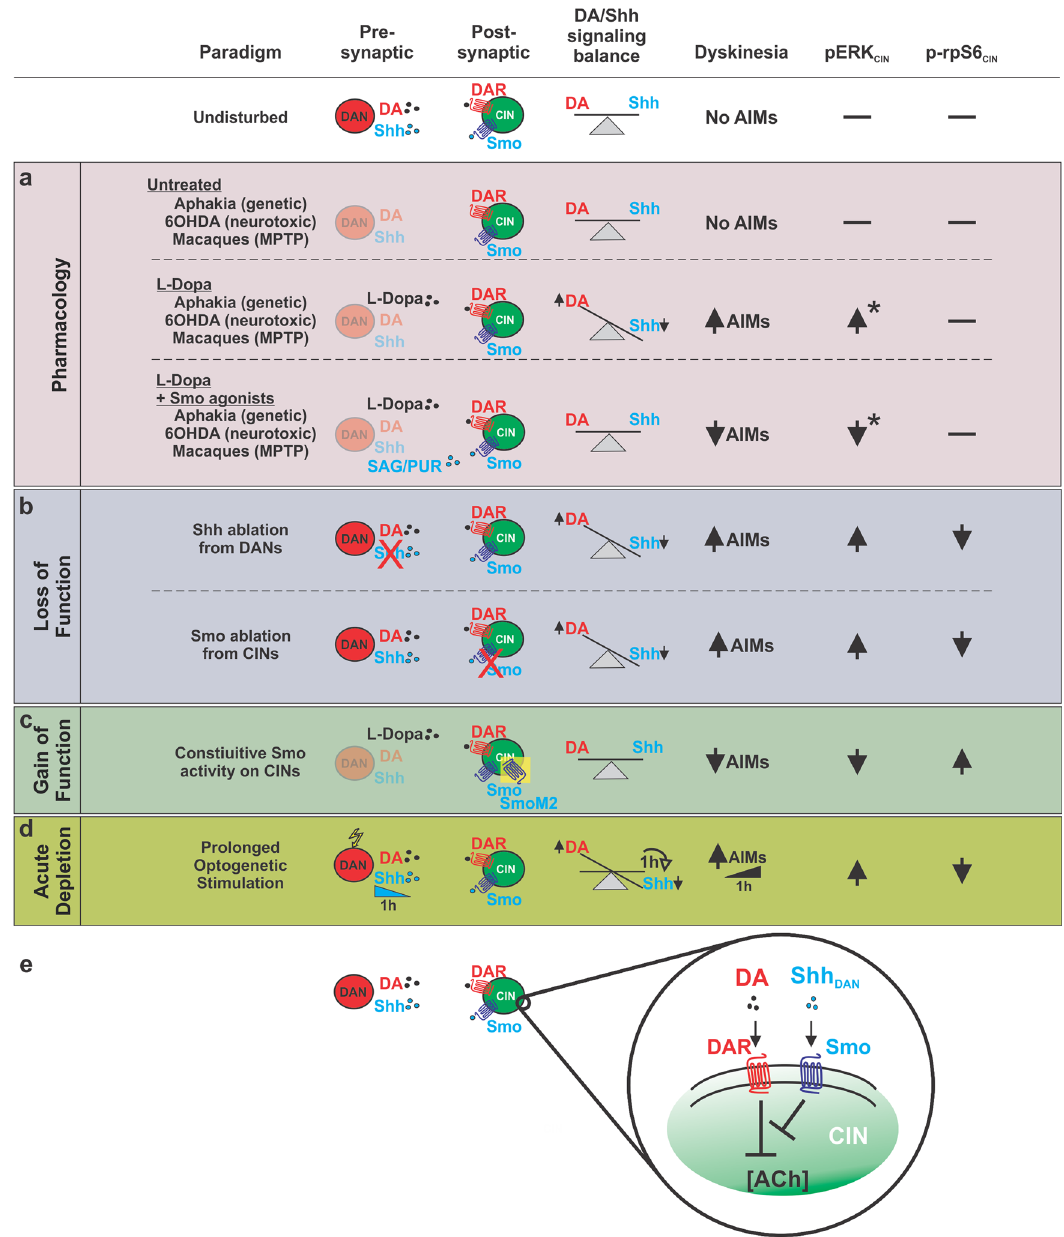
Fig. 8 Manipulation of Shh signaling between DAN and CIN modulates LID, pERK, and p-rpS6 across multiple paradigms spanning time scales and degrees of DAN denervation. a – d Across the animal models of Parkinson ’ s Disease and experimental paradigms utilized in this study, a relative imbalance between Shh (low) and DA (high) signaling onto CIN was consistently observed to induce LID-like pathology. This pathology was accompanied by decreases in neuronal activity marker p-rpS6 and increases in LID histological marker pERK among CIN of the DLS. States de fi ned by relatively low Shh and high DA signaling onto CIN facilitated LID. Postsynaptic manipulations of Smo on CIN produced effects mimicking the complementary pharmacological and presynaptic manipulations suggesting CIN are the relevant cell type through which Shh-dependent modulation of LID occurs. DAN are the physiological source of Shh on which CIN depend and ablation of Shh from DAN produced LID-like behavior and changes in CIN pERK and p-rpS6 levels. Further, not only was acute Smo pharmacology suf fi cient to rapidly attenuate LID following SAG administration, but prolonged optogenetic stimulation of DAN led to a diminishment of Shh signaling within the course of a single hour and produced behavior resembling that observed in LID. Thus the relative balance between DA and Shh signaling onto CIN is not only perturbed following drastic denervation of DAN, but can vary at shorter time scales. e The fi ndings derived from these distinct paradigms indicates that the Shh/Smo signaling pathway counteracts DA signaling in CIN. *Changes in pErk determined from examination of murine 45 min following drug administration. Asymmetry of locomotion was cal- culated as a percentage of lesion ipsilateral to contralateral turning bias.